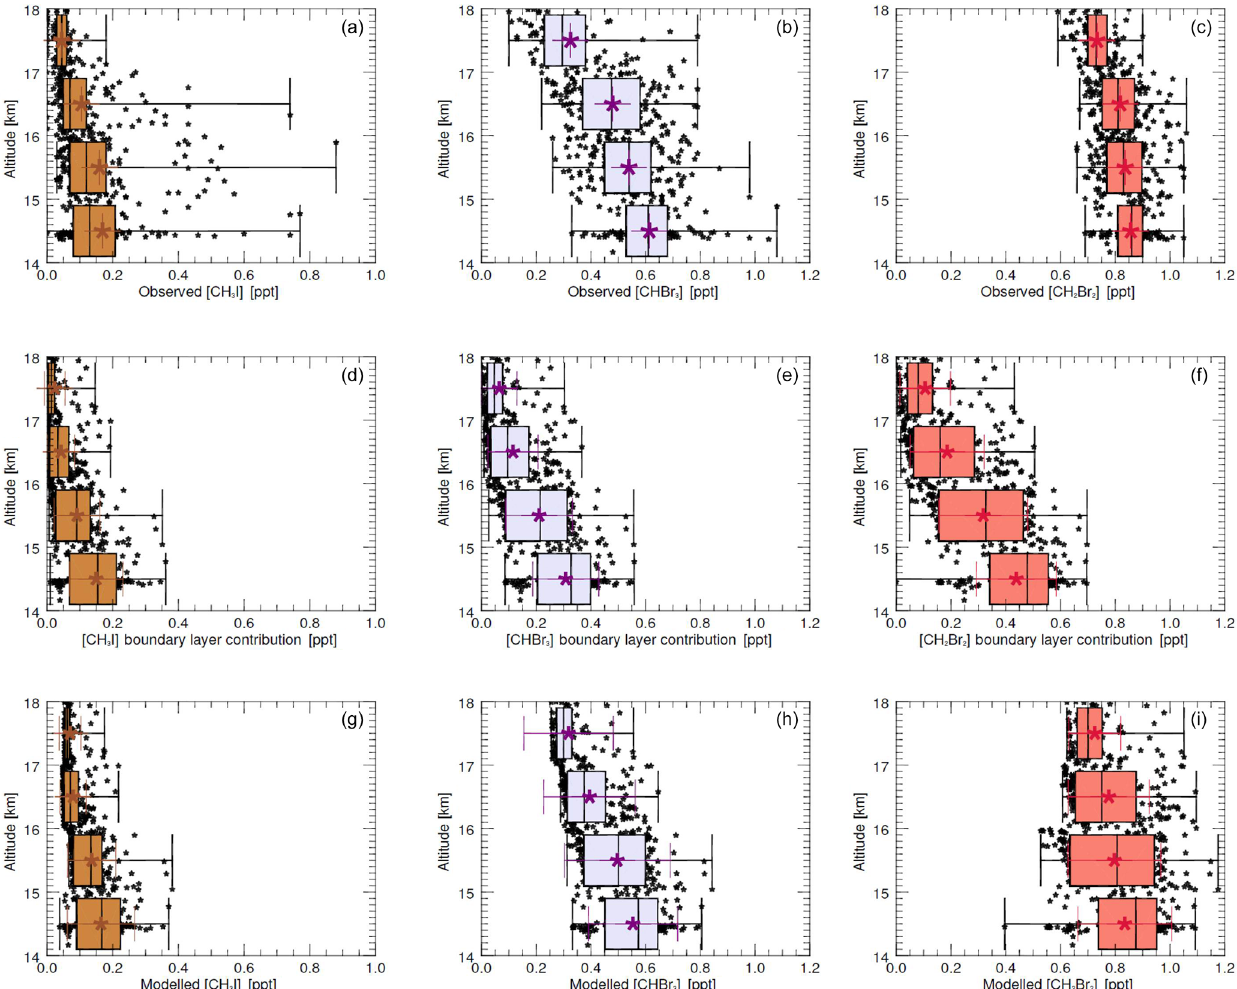
Figure 7. CH 3 I, CHBr 3 and CH 2 Br 2 vertical distribution in the TTL for ATTREX 2014 flights.: AWAS observations (a–c) , NAME-modelled boundary layer contribution (d–f) , and NAME-modelled sums of boundary layer and background contributions (g–i)